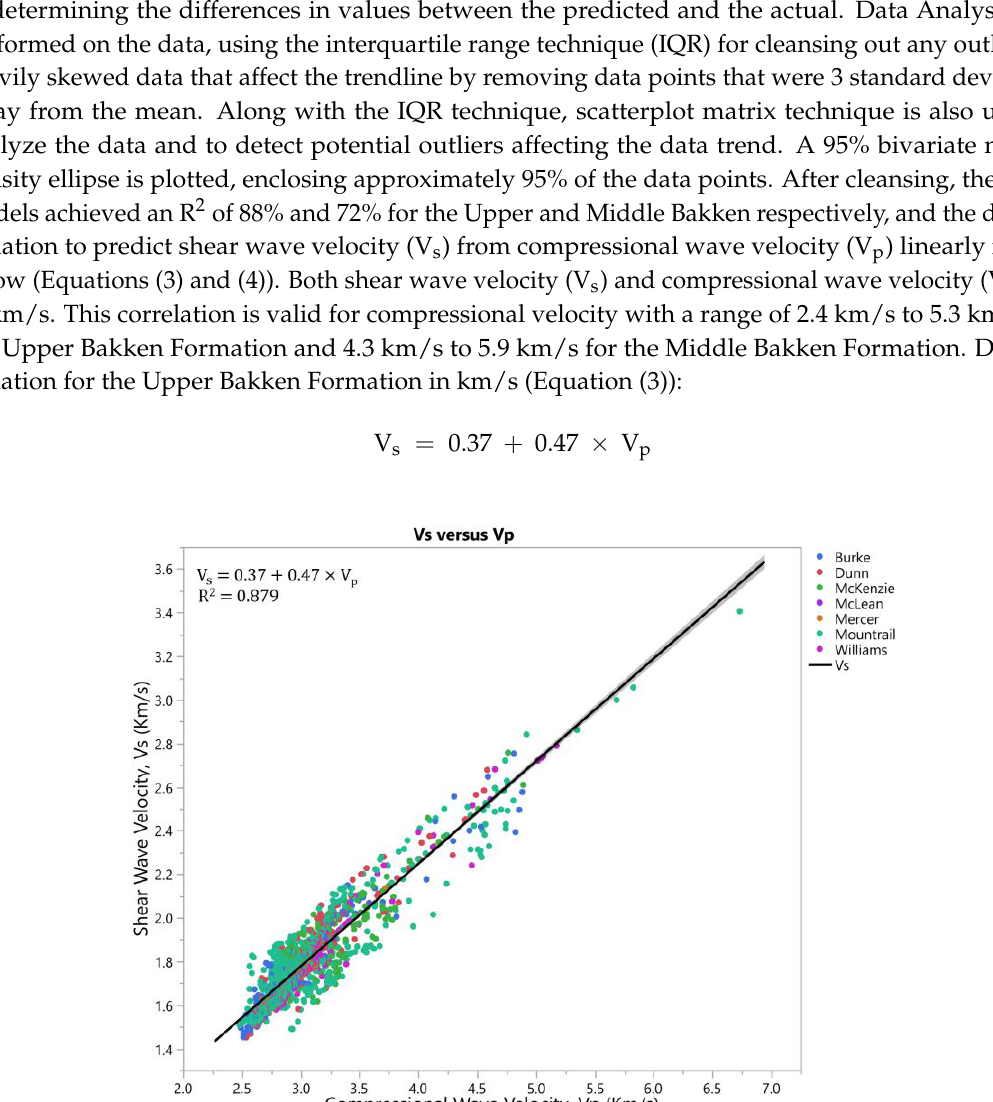
( b ) Figure 14. ( a ) Shear wave velocity versus compressional wave velocity for the Middle Bakken Formation. ( b ) Shear wave velocity versus compressional wave velocity with respect to gamma ray for the Middle Bakken Formation.